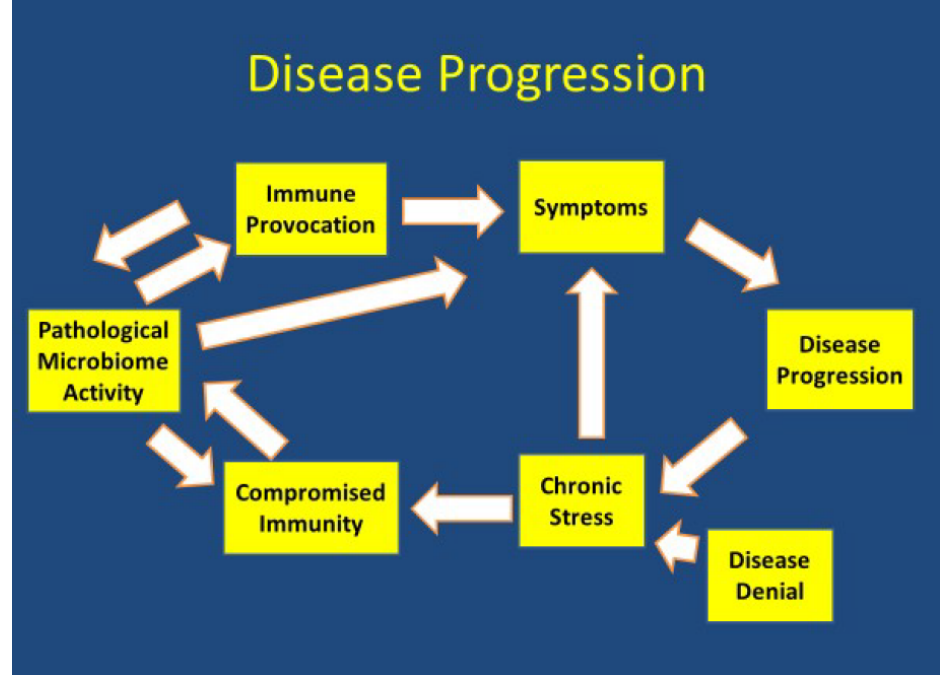
Figure 1. Disease